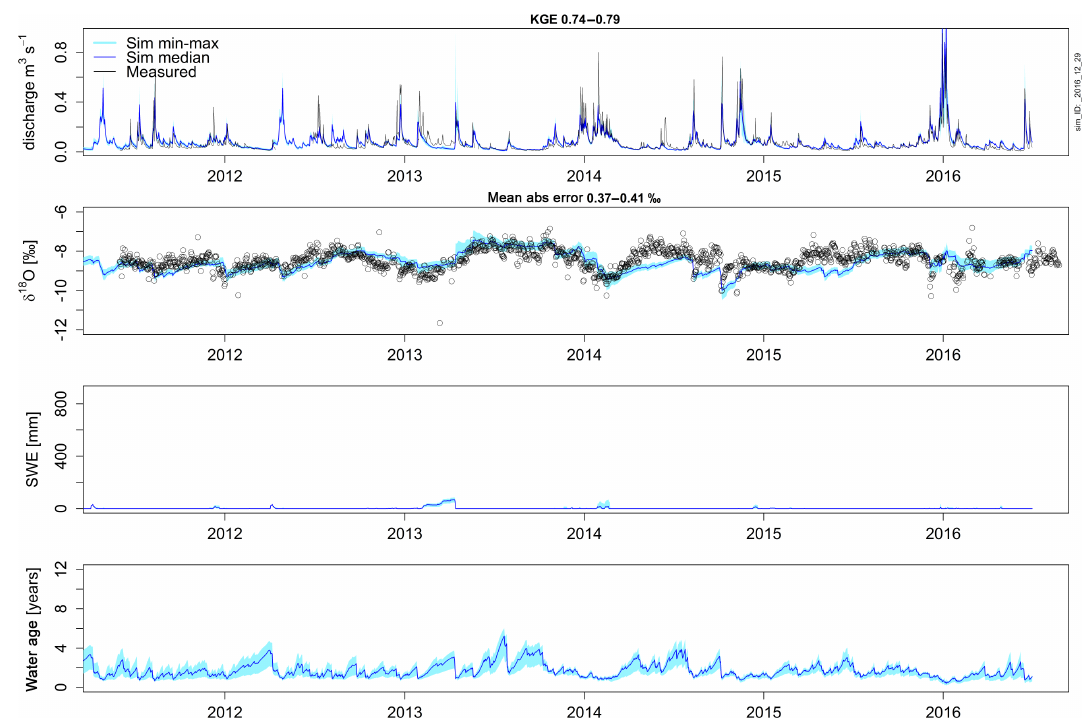
Figure 6. Bruntland Burn simulation output: top panel shows the streamflow, second panel the isotope ratio at the stream outlet, third panel the SWE, and the lowest panel the simulated stream water age. GOF measures are shown on plot